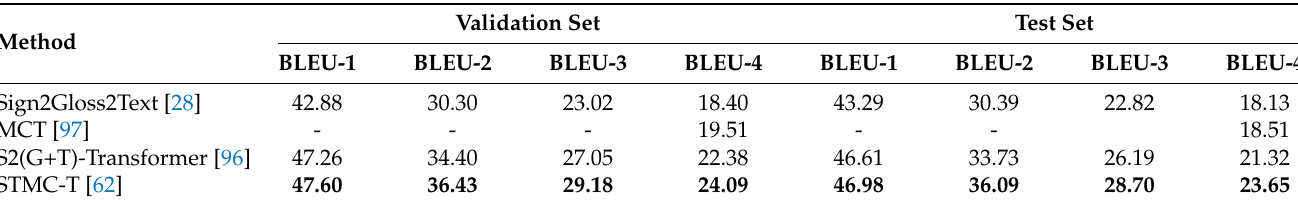
Table 4. Reported results on sign language translation on Phoenix-2014-T. The best performance appears in bold. Validation Set Test Method